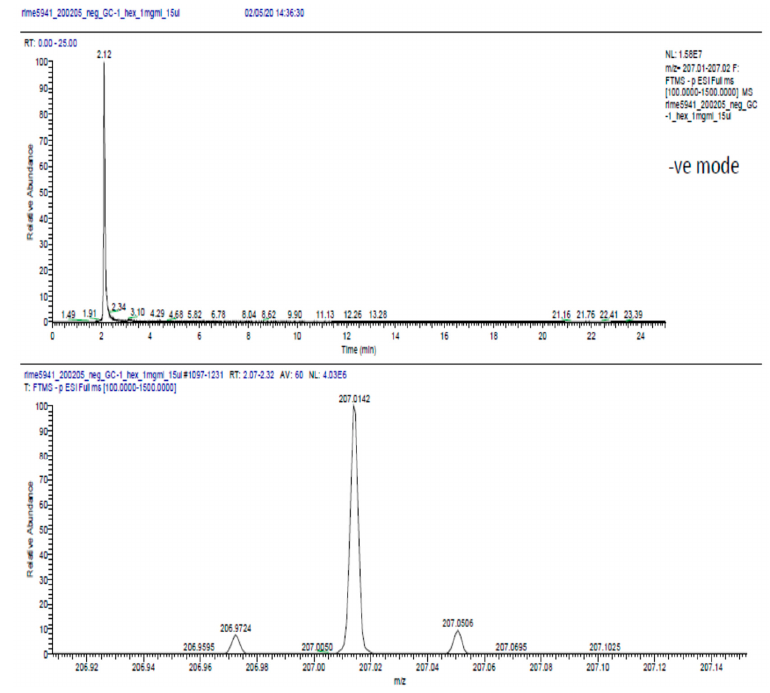
Figure A1. UPLC-MS analysis of the n -hexane extract of G. cambogia indicating the presence of garcinol.